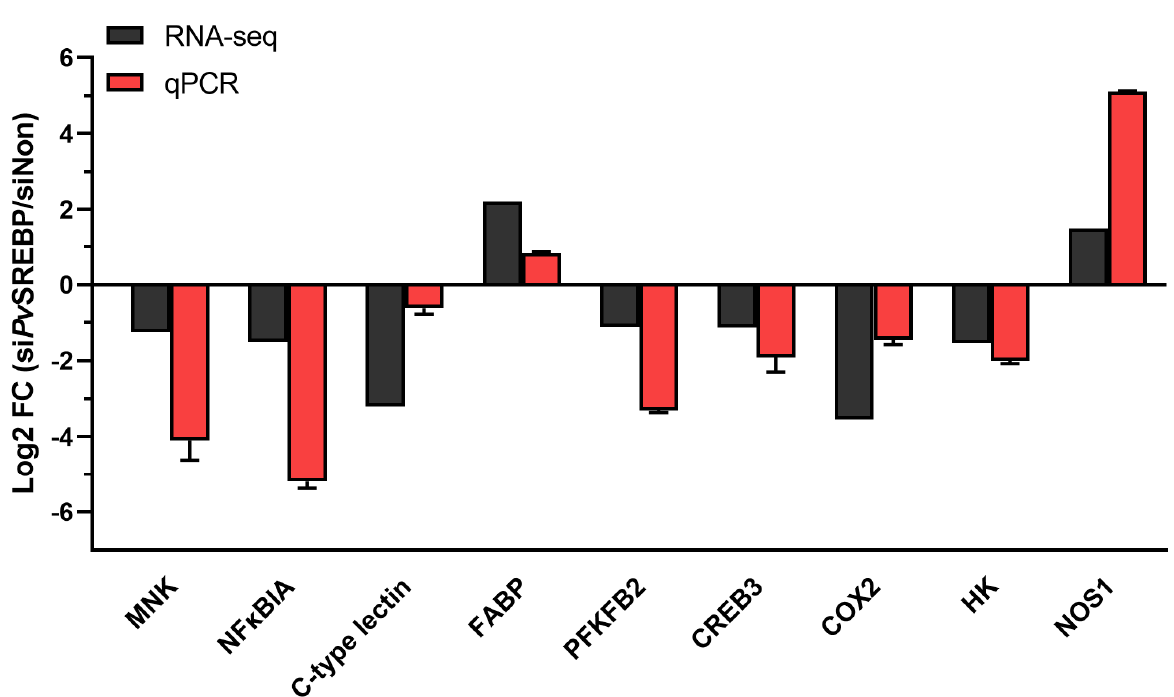
Figure 5. Validation of selected DEGs using qPCRs. The relative expression (fold-change) of nine DEGs was determined by qPCR relative to the expression of the Pv EF1 α gene (internal control). MNK, MAP kinase-interacting serine/threonine-protein kinase 1; NF κ BIA, Nuclear factor of kappa light polypeptide gene enhancer in B-cells inhibitor, α ; C-type lectin; FABP, fatty acid binding pro- tein; PFKFB2, 6-phosphofructo-2-kinase/fructose-2,6-bisphosphatase; CREB3, cyclic AMP response element-binding protein A; COX2, Cyclooxygenase-2 (prostaglandin G/H synthase 2); HK2, hexo- kinase type 2; NOS1, nitric oxide synthase 1.